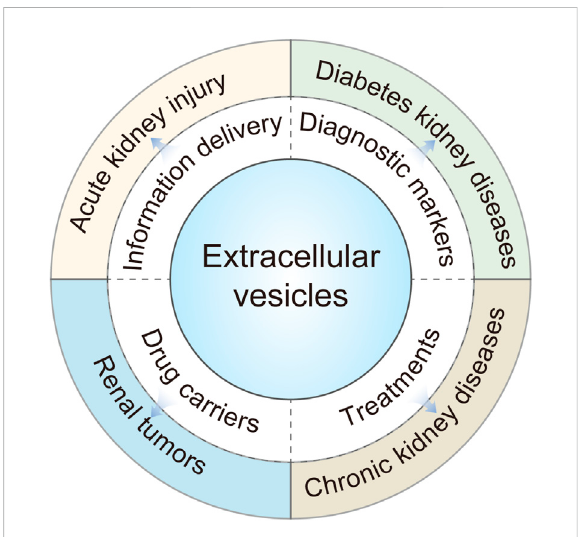
Extracellular vesicles (EVs) play an important role in different types of kidney